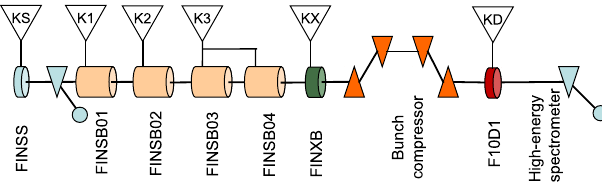
FIG. 9. Schematic layout of the SITF rf system, showing the accelerating structures as cylinders with the corresponding power sources (klystrons).